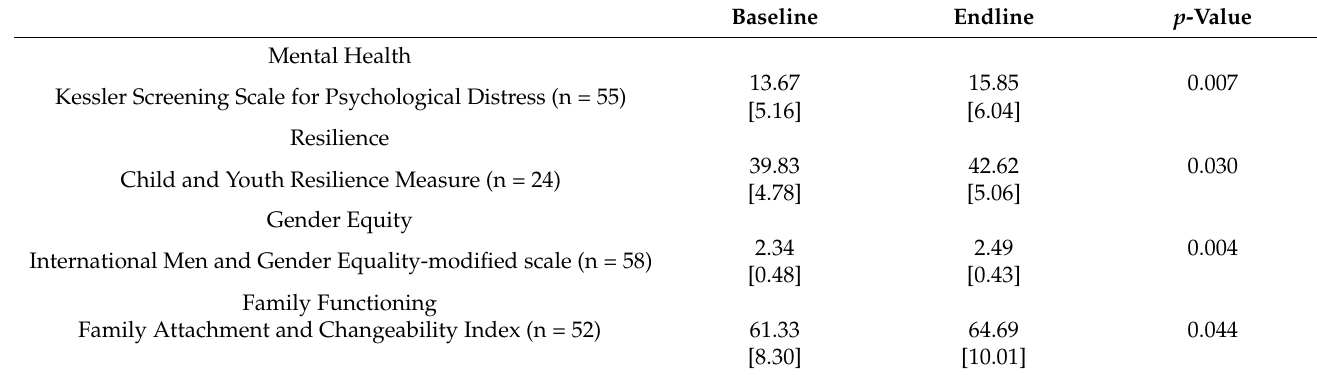
Table 3. Change in outcomes for full panel